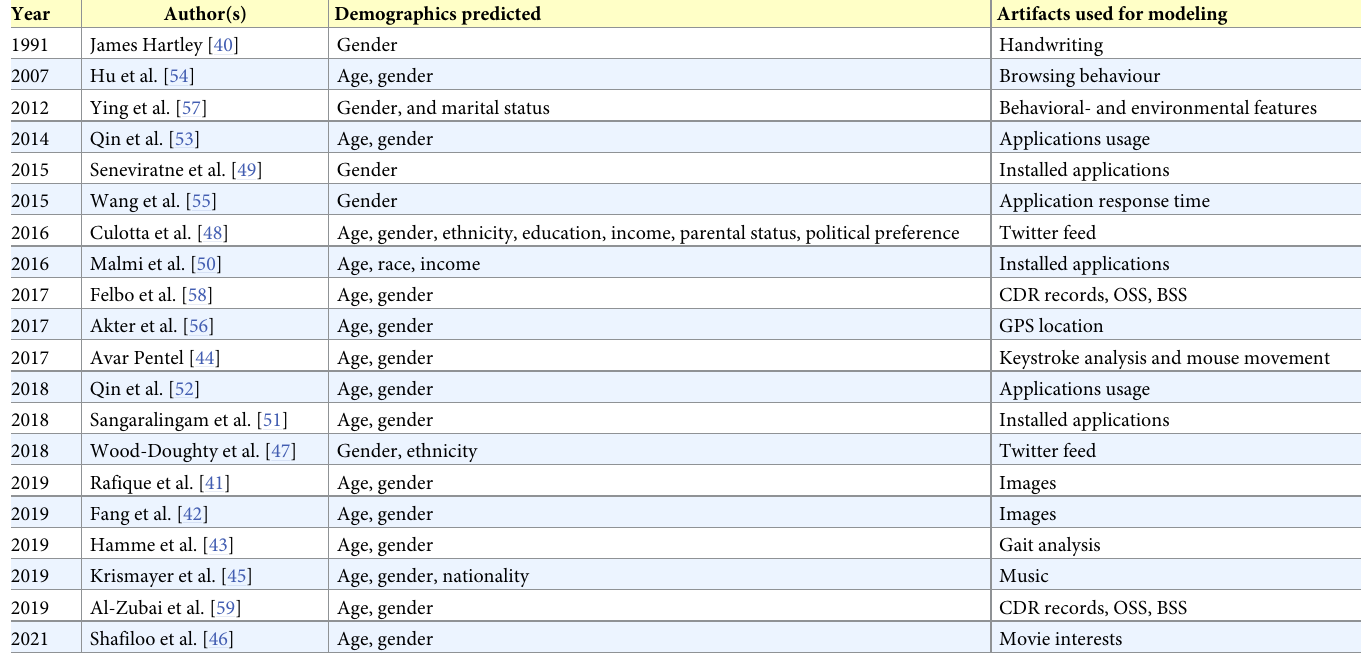
Table 1. Summary of literature